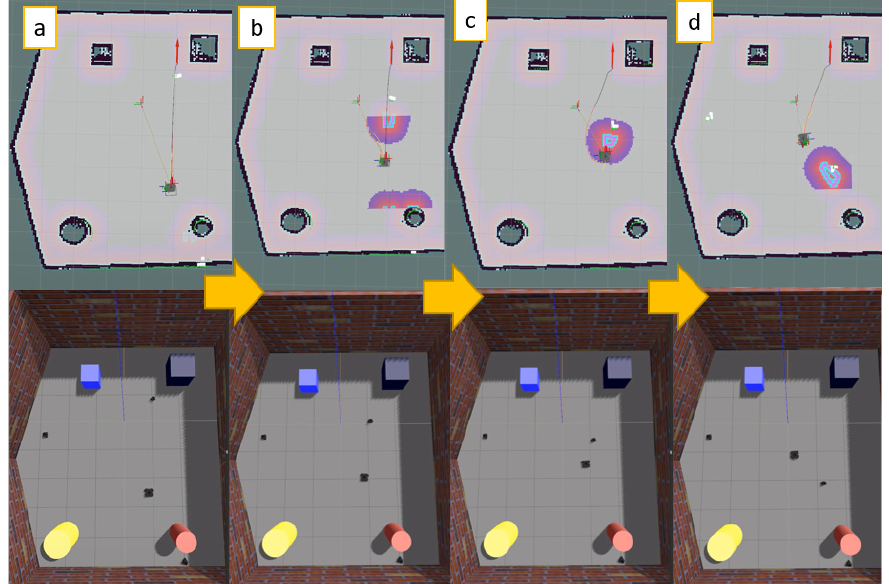
Figure 15. The subfigures ( a – d ) illustrate the obstacle avoidance process of the robot with the obstacle velocity layer, the upper part of which shows the visualization tool, and the lower part shows the simulated environment.